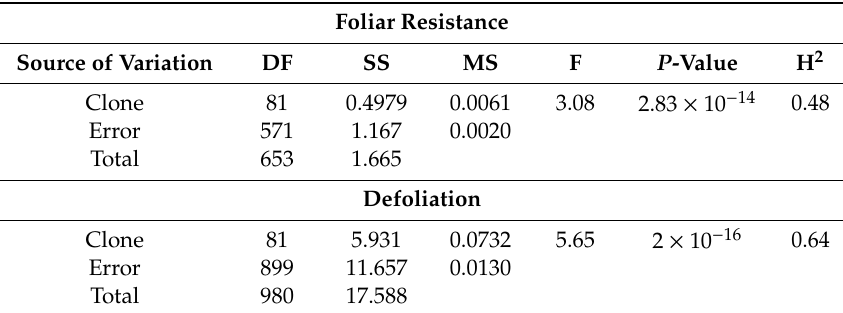
Table 1. Analysis of variance for foliar resistance and defoliation.